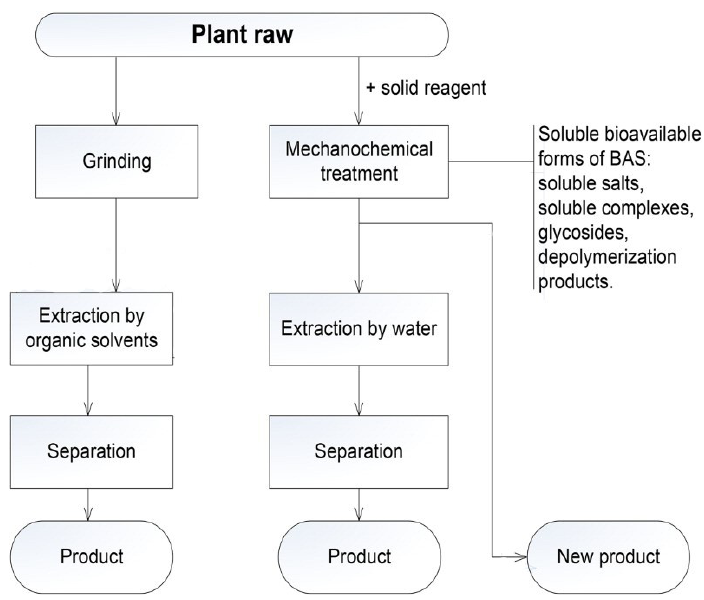
Figure 7. Comparison of the best-known methods for the separation of biologically active substances and mechanochemical extraction from plant materials [61]. and mechanochemical extraction from plant materials